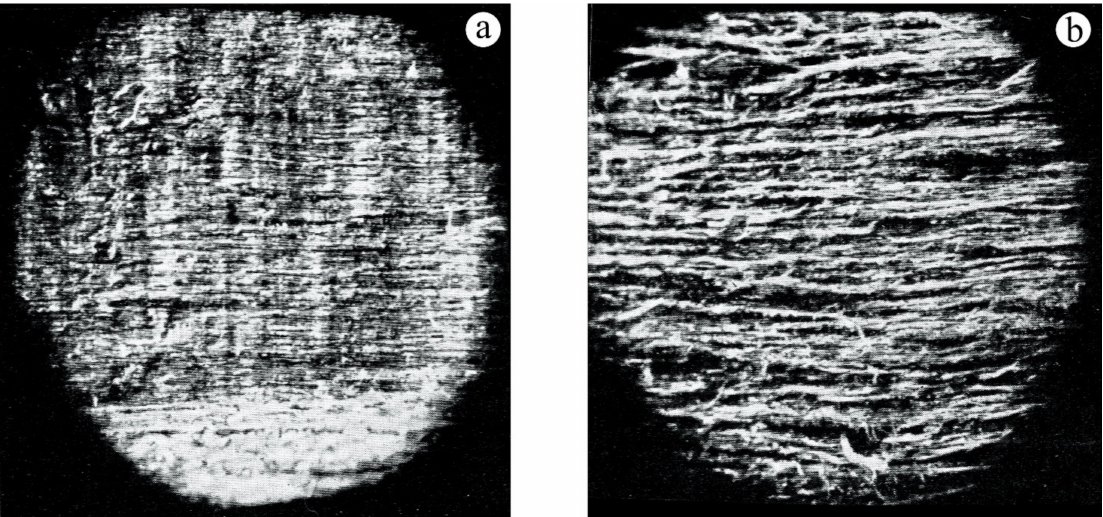
Figure 8. Images on the cleft surface of ( a ) untreated and ( b ) pleated beech wood. Reproduced from [59], with permission from B á der,